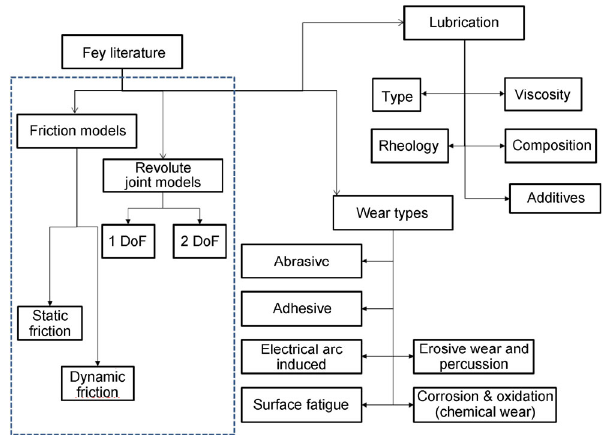
Fig. 2 Factors influencing the manipulator mechanism. This blue box highlights the focus areas of this paper, i.e., dynamics and friction with reference to manipulator